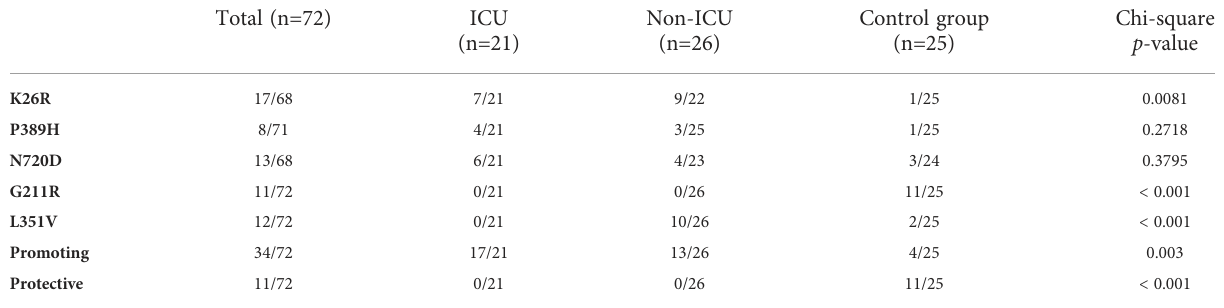
TABLE 2 ACE2 SNP distribution of the sample population.